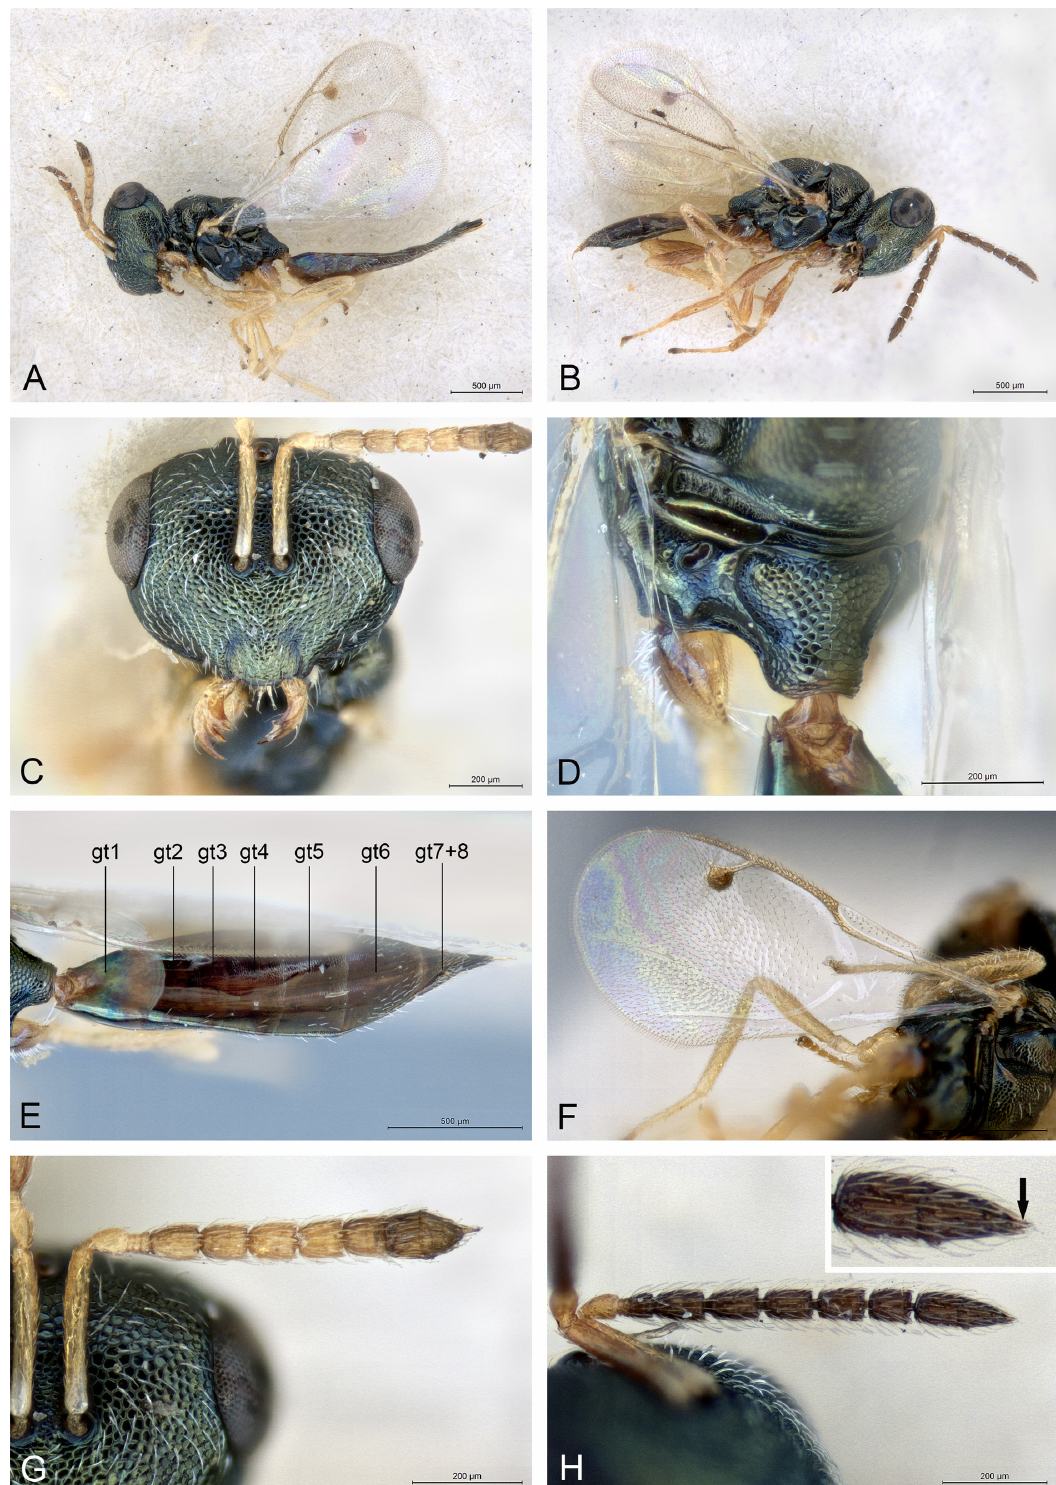
Fig. 2. Habritella mandibulata sp. nov. A, C, G . Holotype, ♀ (NHMUK). B, H . Allotype, ♂ (NHMUK). D–F . Paratype, ♀ (NHMUK). A . Habitus in lateral view. B . Habitus in lateral view. C . Head in frontal view. D . Detail of mesosoma in dorsal view. E . Metasoma in dorsal view. F . Fore wing in dorsal view. G . Antenna in lateral view. H . Antenna in lateral view (inset: detail of clava indicating the terminal 164